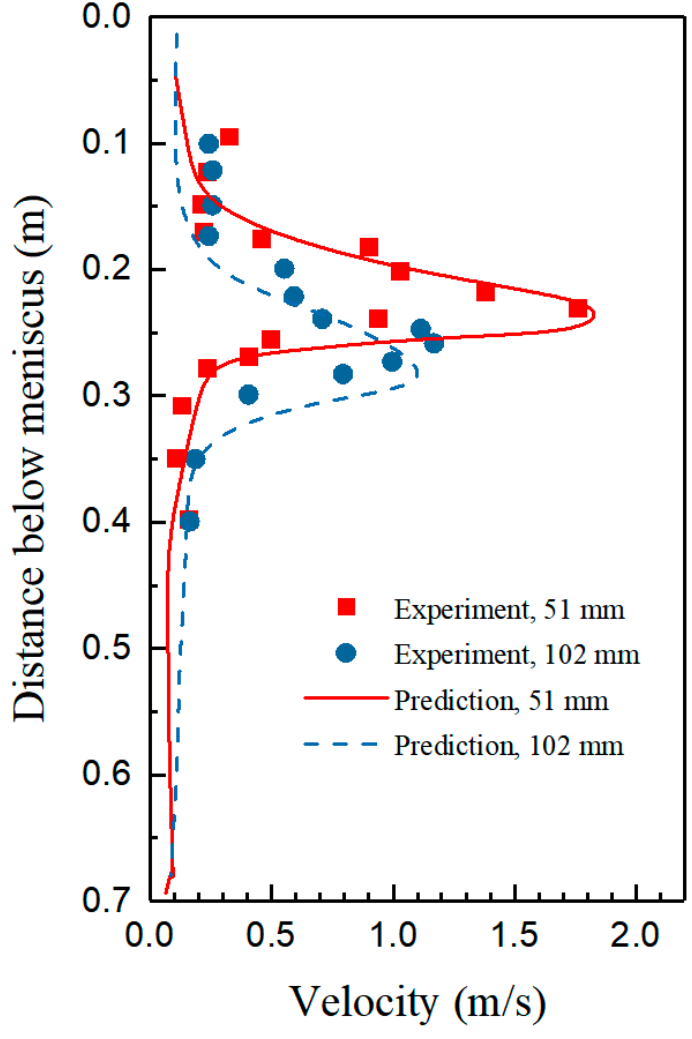
Figure 1. Comparison of predicted velocities in the LBM model and measurements in a water model at a distance of 51 mm and 102 mm from the SEN [25].